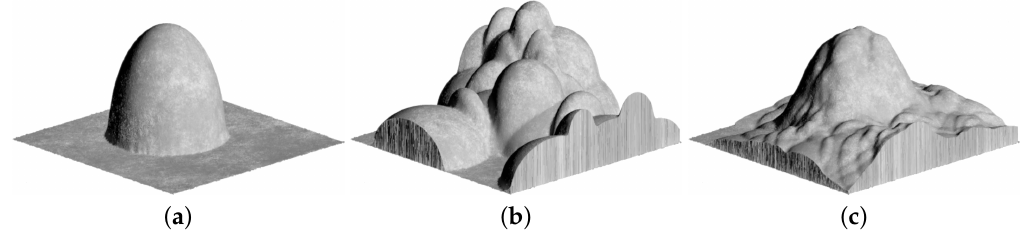
Figure 4. Model generated by circular function of the fault. (Grid resolution: 100 × 100; fault radius (each): r = 25; fault height (max in centre): 0 (cid:54) ∆ h (cid:54) 1). ( a ) 1 fault. ( b ) 10 faults. ( c ) 50 faults.